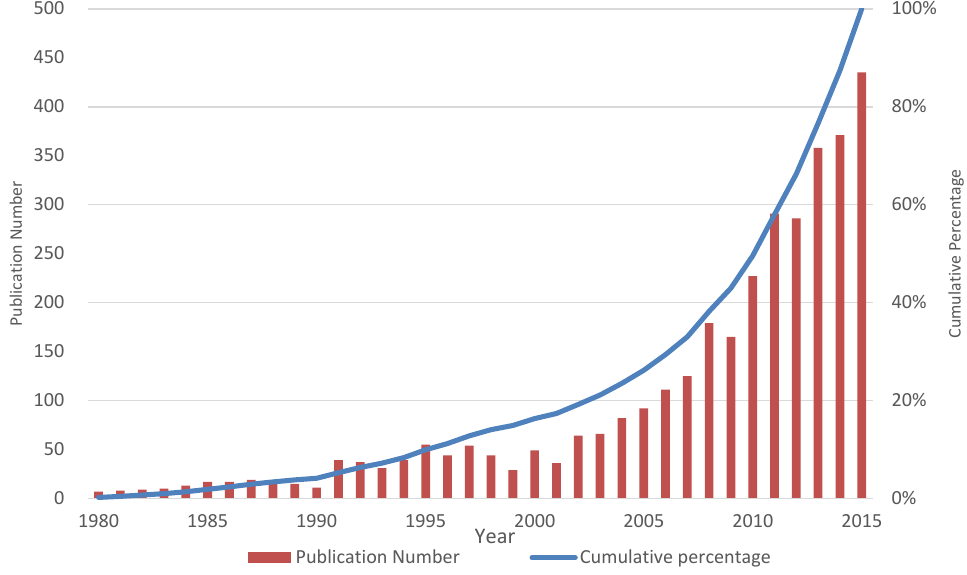
Figure 2. The publication number (red column) and cumulative percentage (blue curve) from 1980 to 2015.